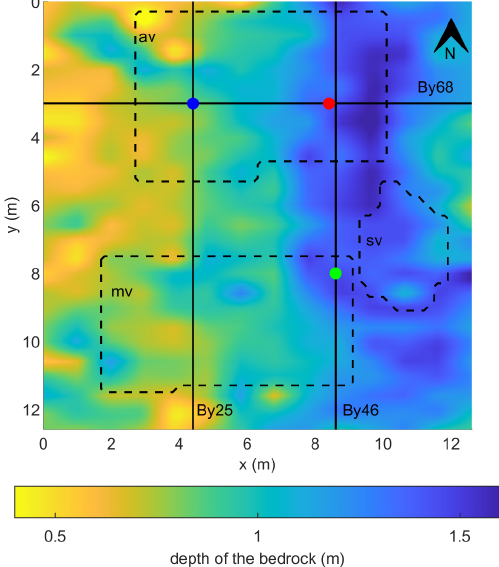
Figure 5. Variations in the thickness of the peat layer, i.e., depth to the granite bedrock. The positions of the three selected IP profiles By 25, By 46, and By 68 are indicated (solid lines) as well as the position of the sampling points and the geometry of the three classes of vegetation cover: abundant vegetation (av), moderate vegetation (mv), and sparse vegetation